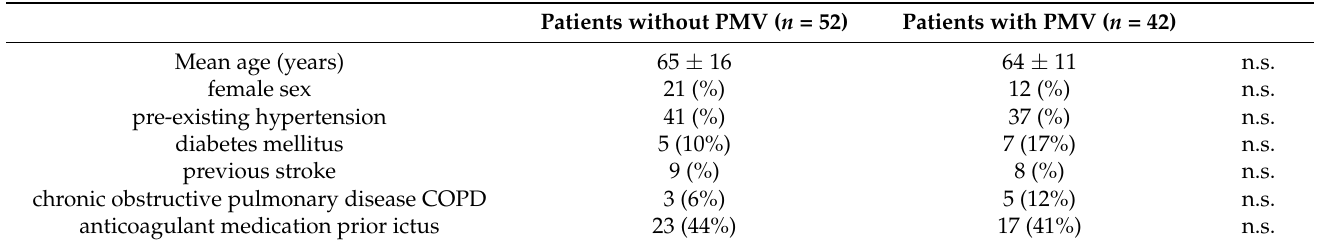
Table 1. Characteristics for patients with deep-seated intracerebral hemorrhage (ICH). Patients without PMV ( n = 52) Patients with PMV ( n = 42) Mean age (years) 65 ± 16 64 ± 11